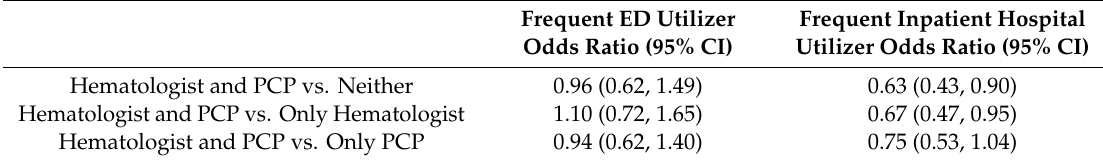
Table 3. Odds Ratios for Utilization and Shared Care